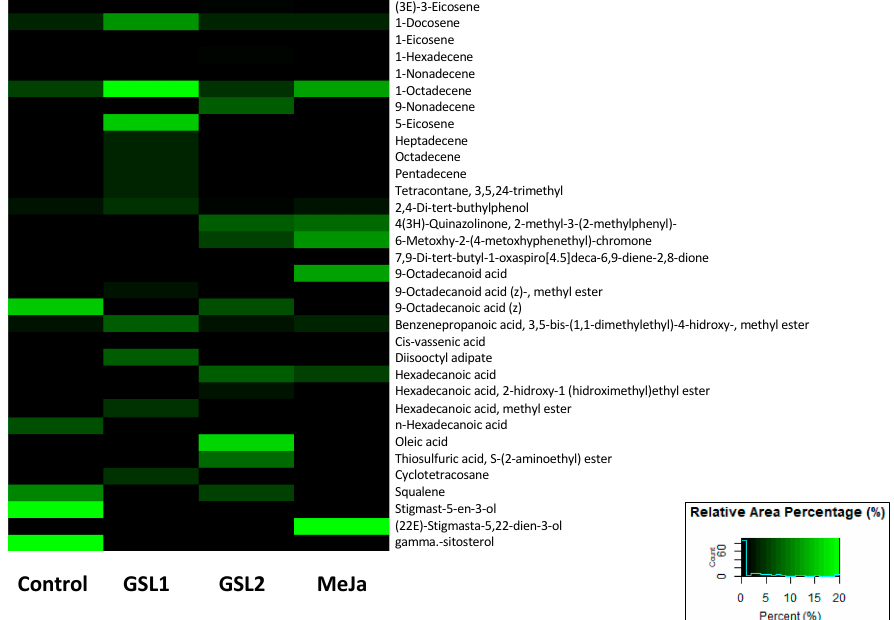
Figure 3. Heatmap of the secondary metabolites abundance of ethyl acetate extracts 20 days after A. malaccensis callus treatment with elicitor derived from F. solani strain GSL1 or GSL2 mycelium, or MeJA. The abundance of the detected compound was presented in a color gradient, with green being the highest and black being the